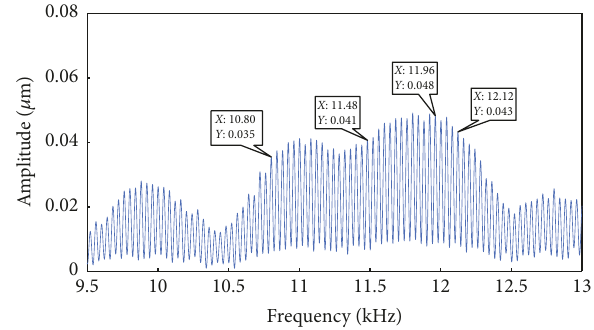
Figure 36: Spectrum of the residual signal of a faulty gear (crack ratio = 25%).